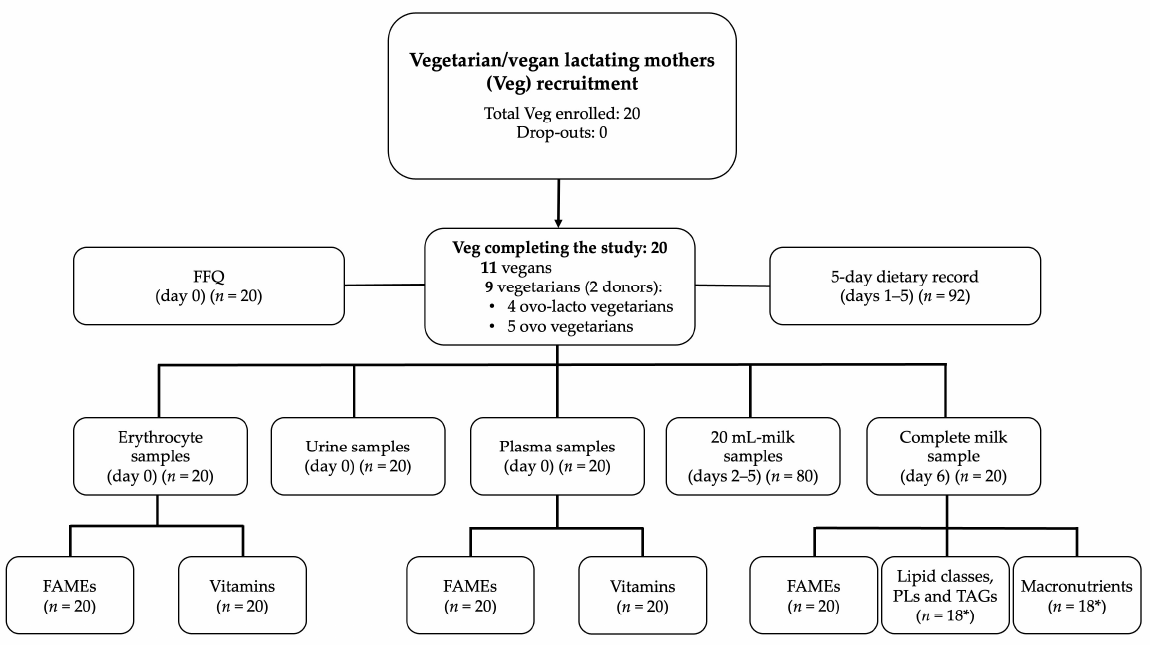
Figure 3. Flow chart for vegetarian/vegan lactating mothers’ (Veg) recruitment and sampling. * Due to two missing data. Abbreviations: FFQ, food frequency questionnaire; FAMEs, fatty acid methyl esters; PLs, relative composition of phospholipids; TAGs, molecular species of triacylglycerols.